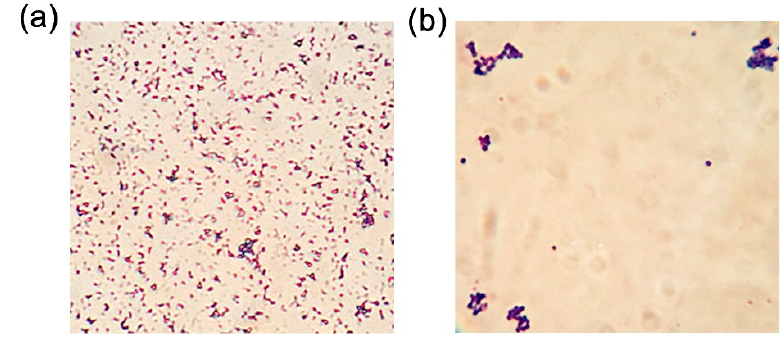
Figure 6. The optical images of MIPs absorbing ( a ) L. monocytogenes and ( b ) S. aureus .